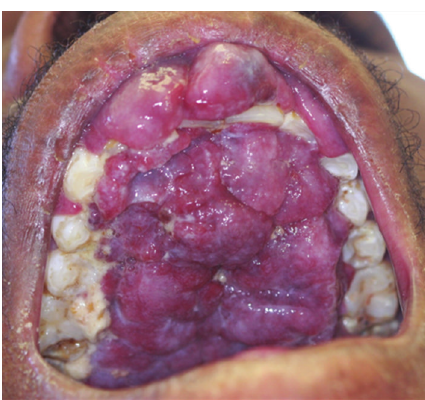
Figure 2: Exophytic confluent oral HIV-KS lesion on the hard palate in a 31-year-old male patient with a CD4+ T-cell count of 5cells/mm 3 .